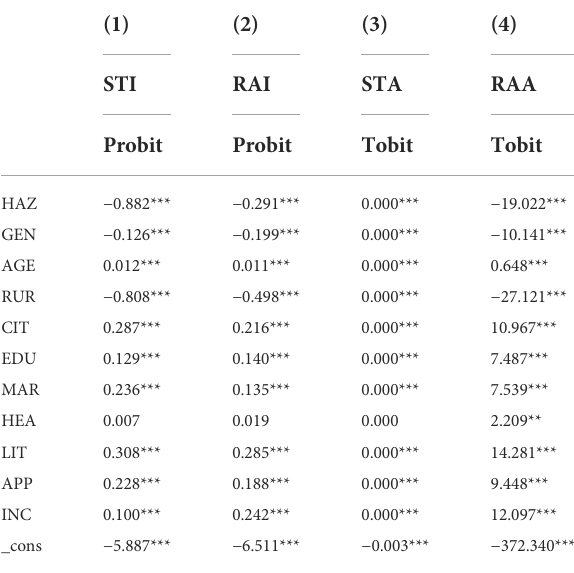
TABLE 2 Regression of the impact of natural hazards on stock investment and risk asset investment participation and